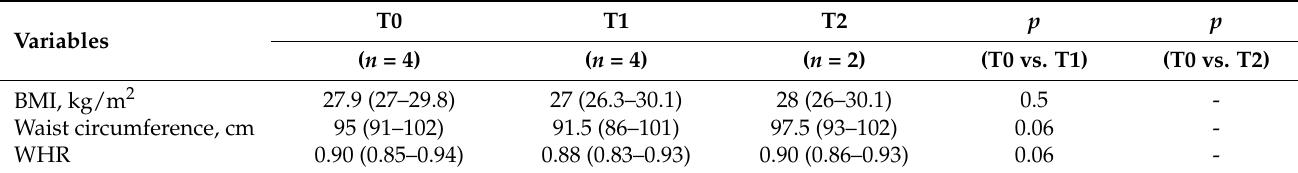
Table 5. Anthropometric parameter changes in women overweight.